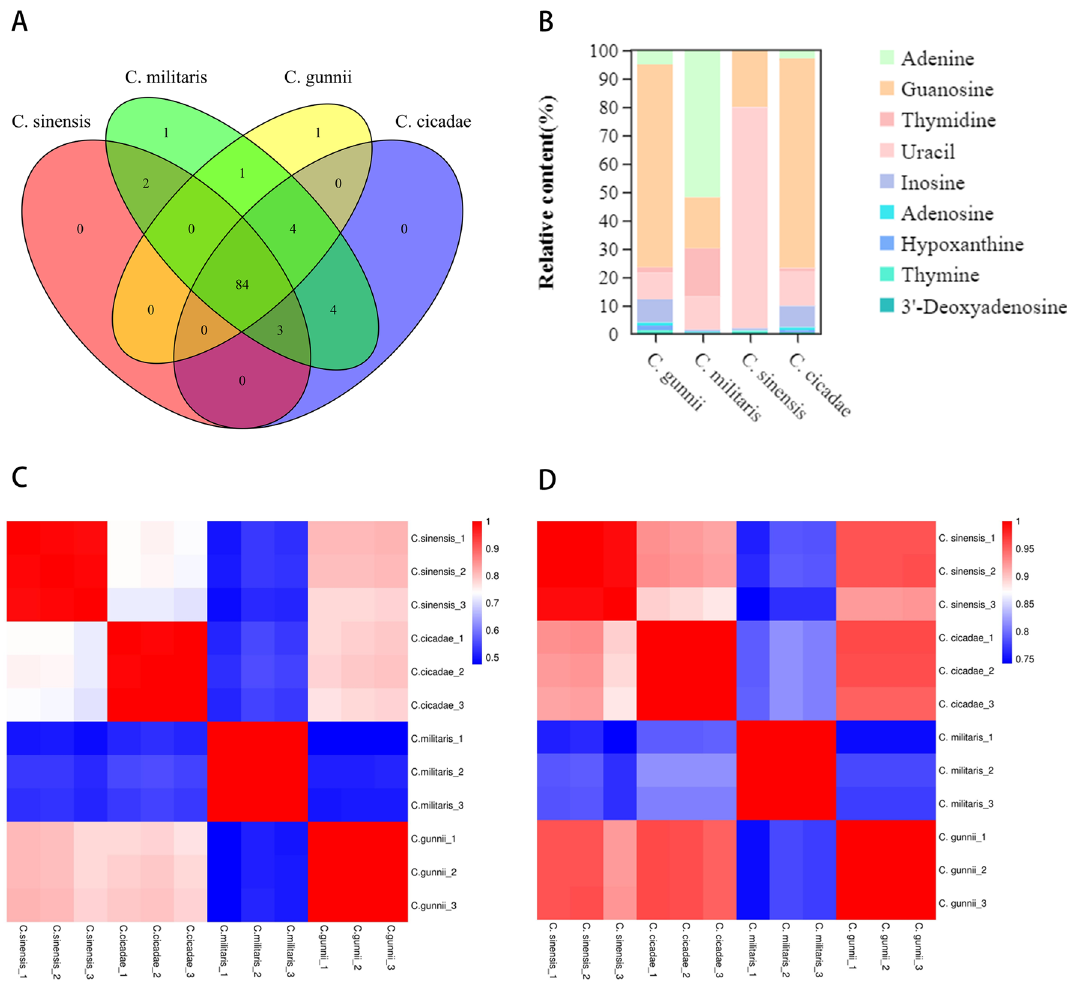
Figure 5. Analysis of nucleoside metabolites of Cordyceps. ( A ) venn diagram of nucleoside metabolites of C. sinensis, C. cicadae, C. militaris and C. gunnii . ( B ) Histogram of the relative contents of major components in nucleoside metabolites of C. sinensis, C. cicadae, C. militaris and C. gunnii . ( C ) Pearson correlation heat map of all metabolites of C. sinensis, C. cicadae, C. militaris and C. gunnii. ( D ) Pearson correlation heat map of nucleoside metabolites of C. sinensis, C. cicadae, C. militaris and C.